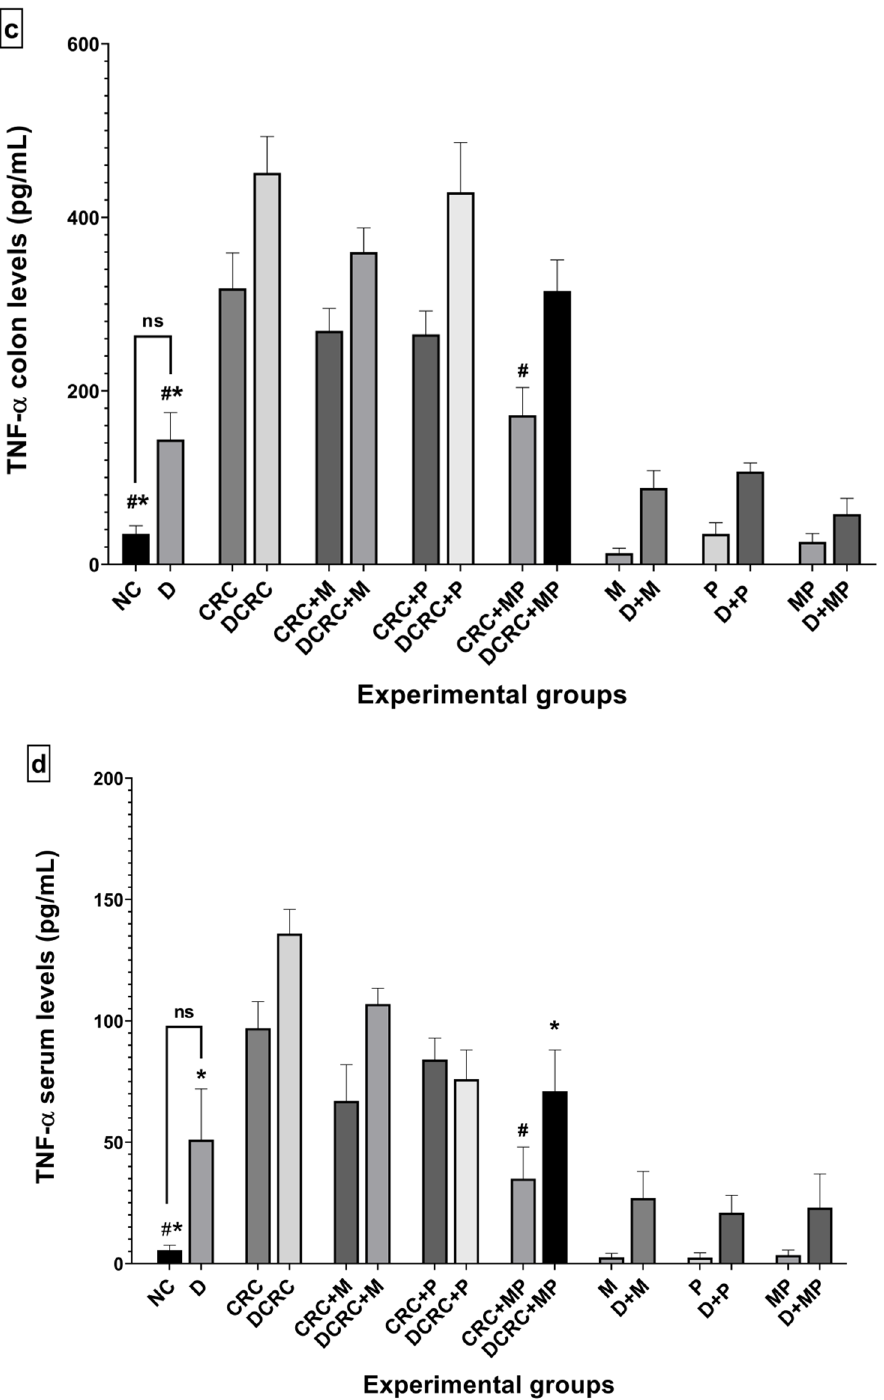
Figure 11. Variation of IL-6 and TNF- α levels from colon extraction ( a , c ) and serum ( b , d ) of the different groups. Results are expressed as mean ± SEM ( n = 4). Nondiabetic groups were compared to their experimental CRC control (CRC); significance was expressed by # p < 0.05. On the other hand, diabetic groups were compared to their experimental diabetic CRC control (DCRC group); significance was expressed by * p < 0.05; ns stands for nonsignificant.